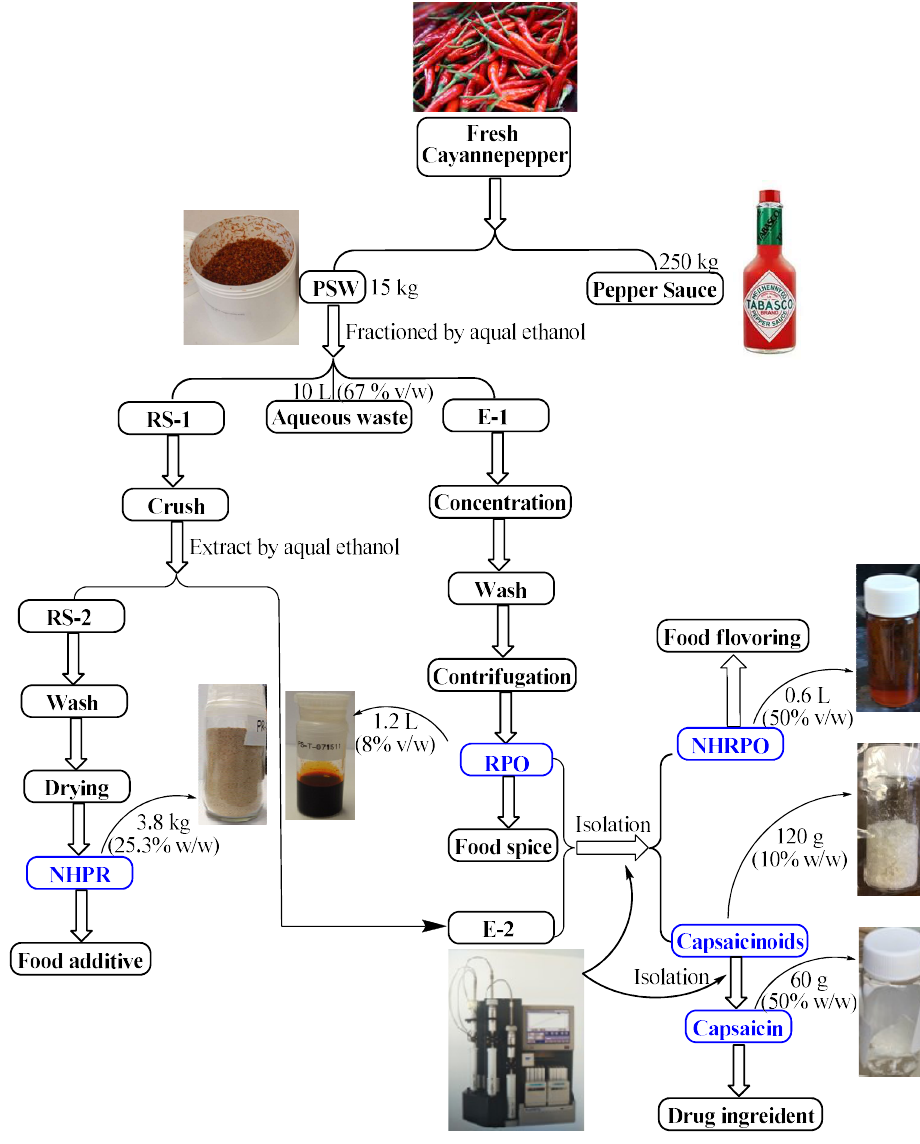
Figure 9. Overview of an integrated process for PSW utilization.